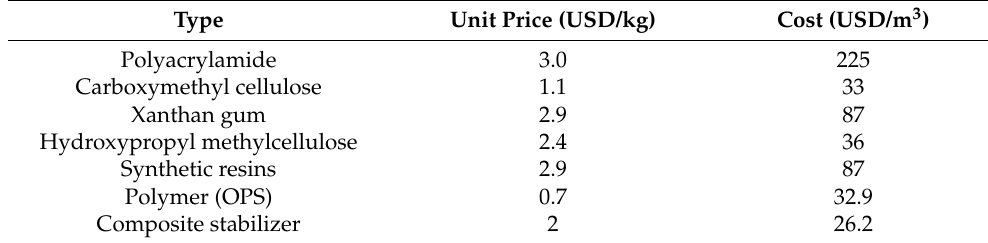
Table 5. Costs of various soil